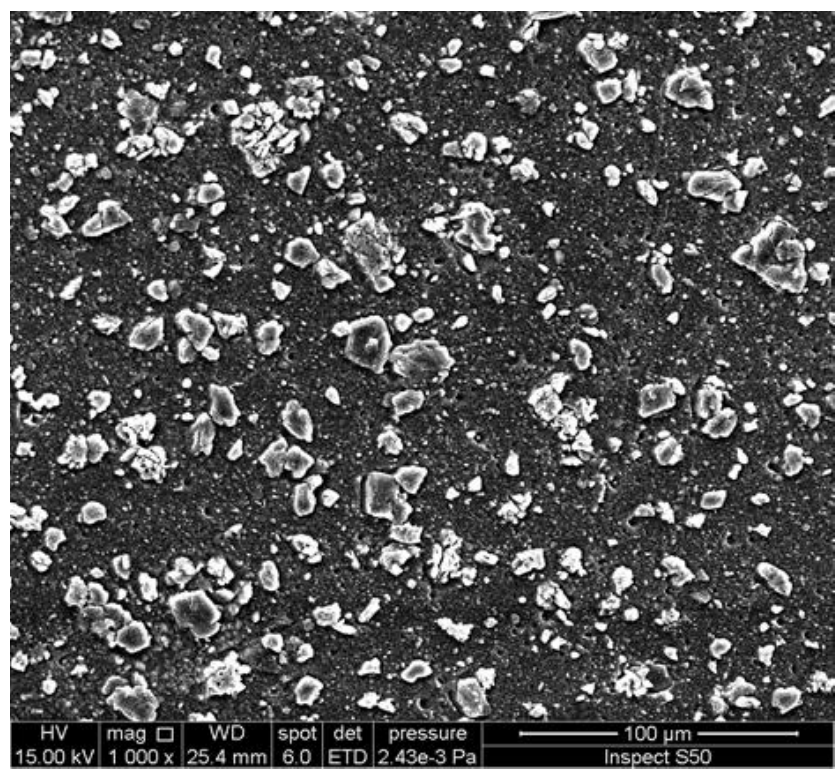
Figure 9. SEM image of the surface of an irradiated PVC film blended with a Schiff base of melamine.